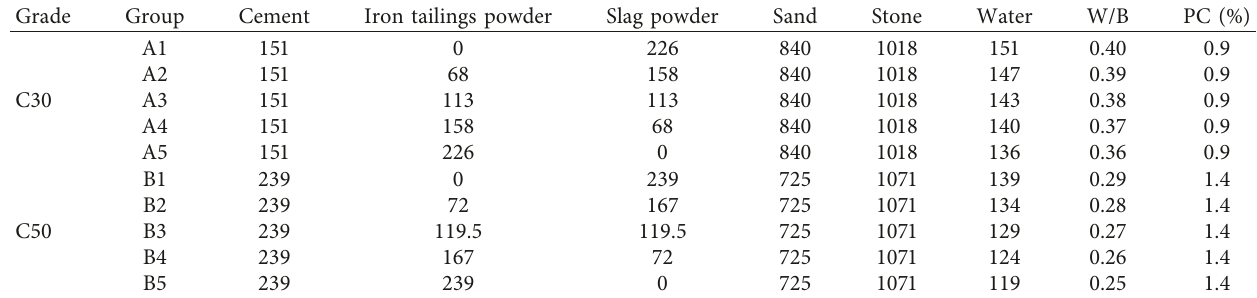
Table 3: Concrete mix proportion (kg · m − 3 ).